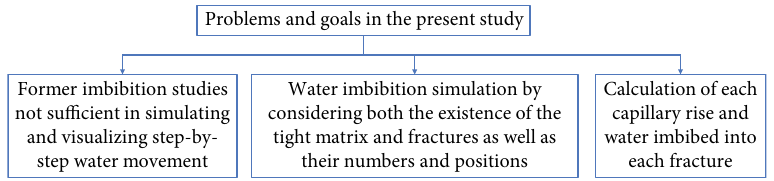
Figure 1: General sketch of the problems posed and goals to be achieved in the present